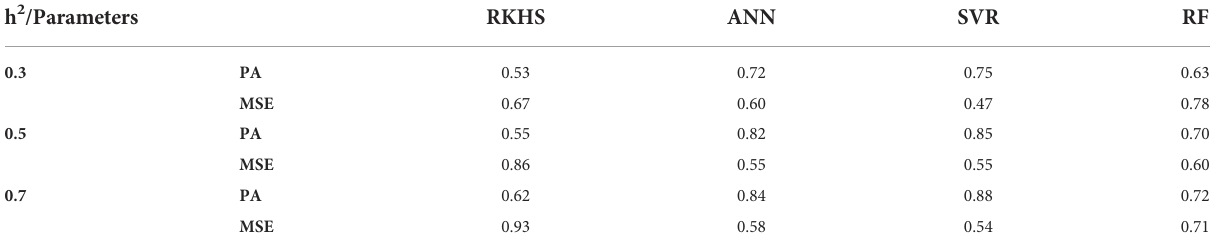
TABLE 2 Predictive ability and MSE of EGVs for different nonparametric methods under study using simulated dataset for various levels of heritability (h 2 ). h 2 /Parameters